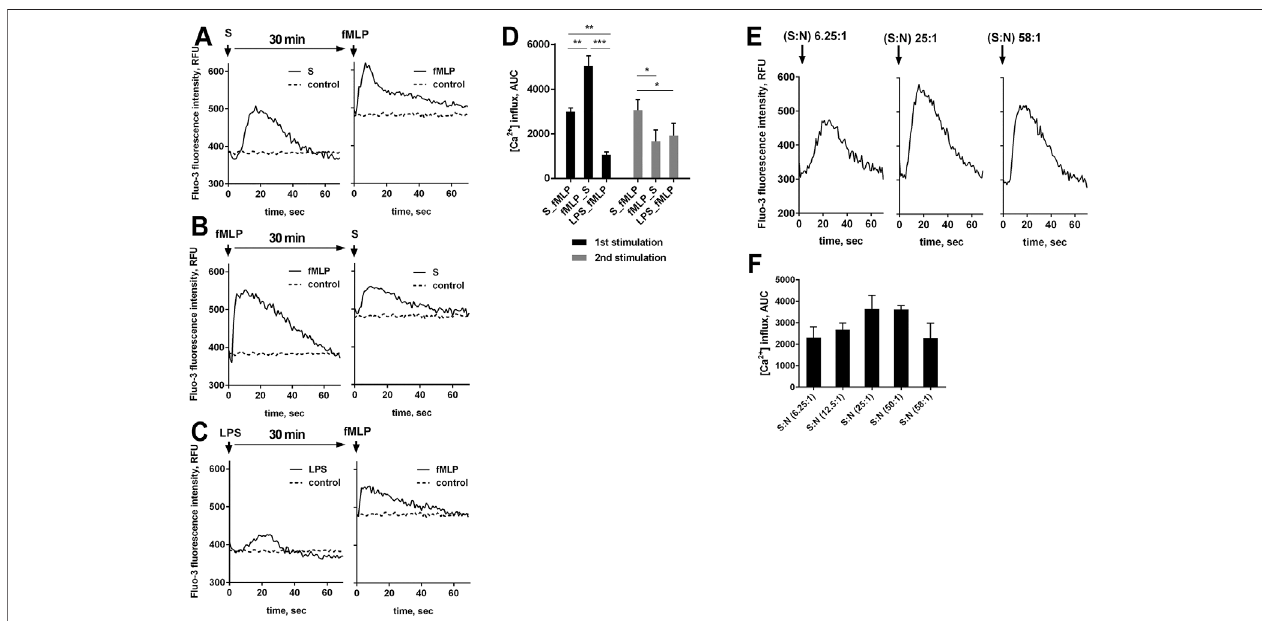
FIGURE 2 | A-D. fMLP-induced increase in [Ca2+]i in the presence of bacteria or LPS. Fluo-3 AM loaded PMNLs (4 × 10 5 /sample) were cultured in fi brinogen- coated fl at bottom 96-well plates in HBSS/HEPES medium at 37 ° C, 5% CO 2 . Cells were sequential exposed to nonopsonized S. typhimurium (S) (bacteria per cell ratio 25:1), LPS (2 μ g/ml) and 0.1 µM fMLP with an interval of 30 min (the order of adding stimuli is shown in the fi gure). HBSS/HEPES was added to control samples (dotted lines on A-C). Flash kinetic of Fluo-3 fl uorescence (ex. 488 nm, em. 535 nm) was monitored with 1 s interval. (A, B, C) Changes in [Ca 2+ ] i are presented as